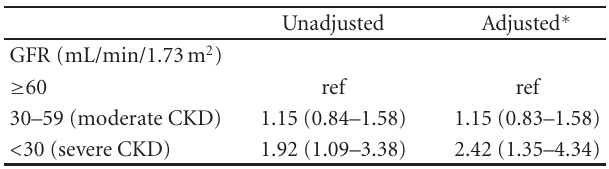
Table 2: Hazard ratios with 95% confidence intervals for time to first appropriate shock based on